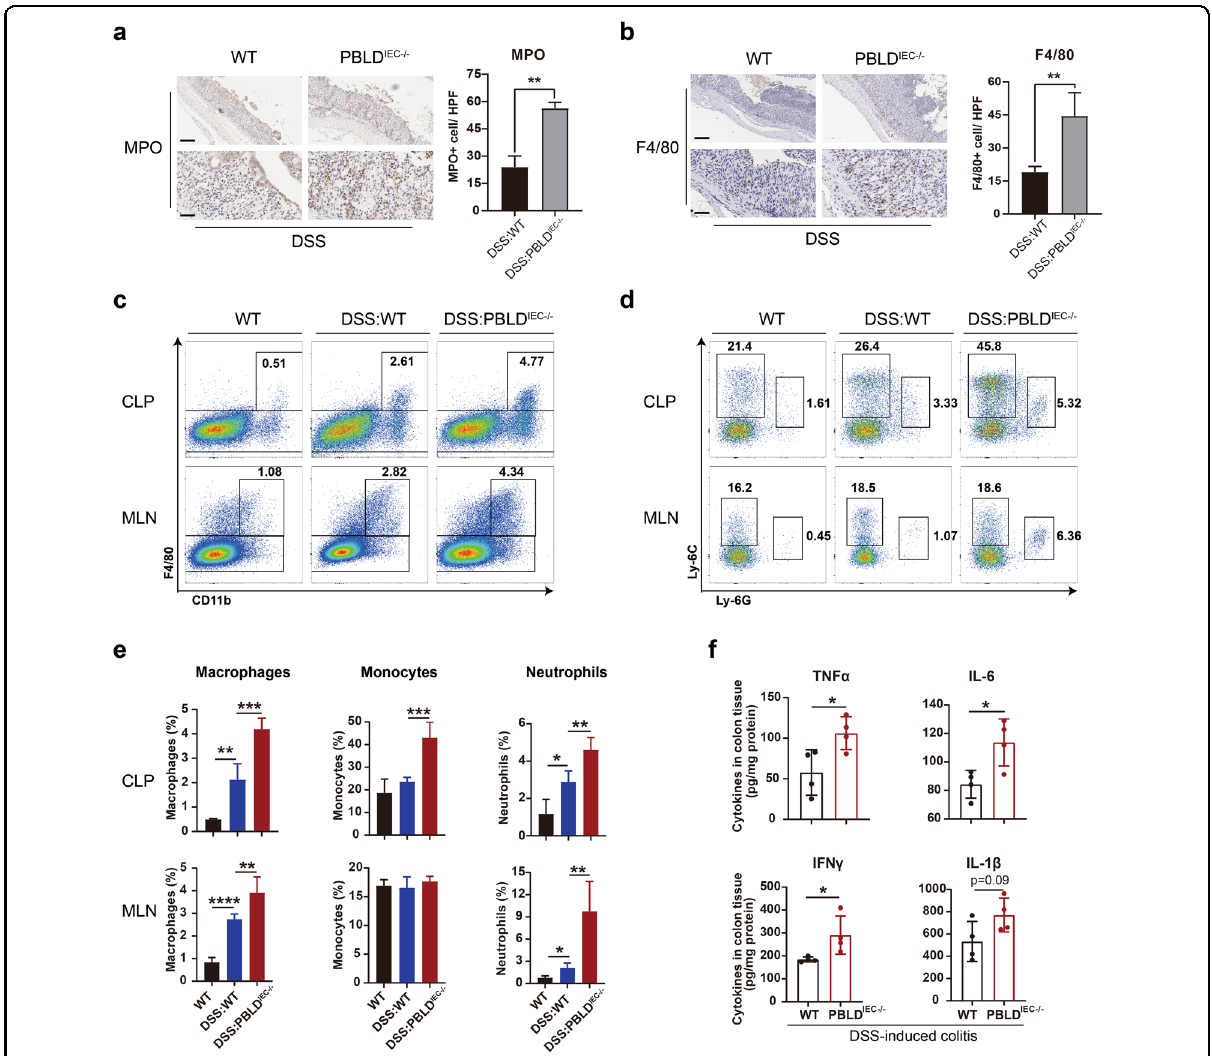
Fig. 5 Epithelial PBLD de fi ciency recruits more immune cells in fi ltration in murine colitis. a Myeloperoxidase (MPO) and ( b ) F4/80-stained colonic tissue sections in mice. Images are representative from three to four mice in each group. Scale bars: 200 μ m in upper in both ( a and b ), 50 μ m in lower in both ( a and b ). c Cells isolated from colonic lamina propria or mesenteric lymph nodes were labeled with anti-F4/80 and anti-CD11b, d anti-Ly-6C and anti-Ly-6G, and then visualized via fl ow cytometry and e their corresponding proportions of macrophages, monocytes, and neutrophils in CLP or MLN. WT, n = 3; DSS:WT, n = 5; DSS:PBLD IEC − / − , n = 5. CLP colonic lamina propria, MLN mesenteric lymph node. f Enzyme- linked immunosorbent assay (ELISA) of whole-colon homogenates in mice to evaluate TNF- α , IL-6, IFN- γ , and IL-1 β production ( n = 4). Data are mean ± standard deviation (SD). * p <